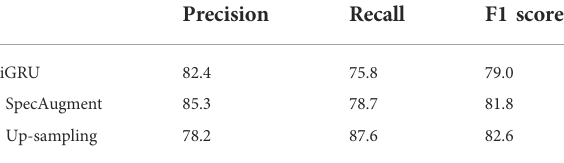
TABLE 2 Laughter detection performance